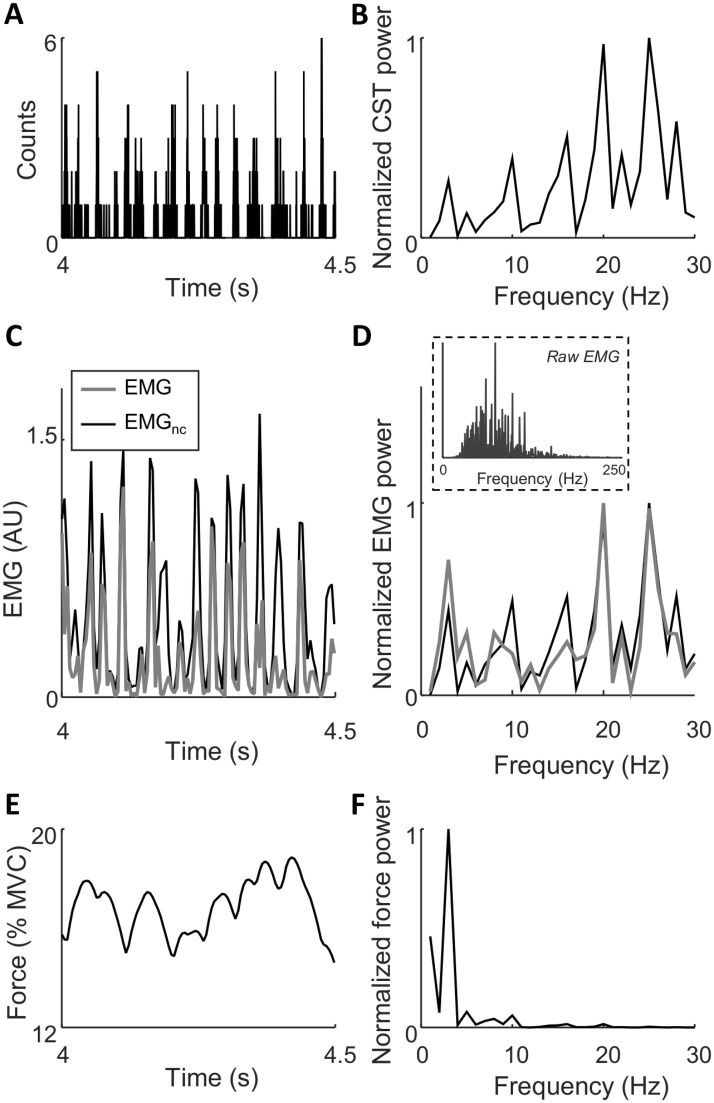
Temporal and spectral representation of the cumulative spike train (CST; A, B), the rectified EMG and EMGnc (C, D), and force (E, F).In panel D, the normalized power spectrum of the raw (unrectified) EMG signal in the 0–250 Hz range is included in the dashed box. In this example, the muscle consisted of 100 motor units, the amplitude of the variability of the common synaptic input was high (force standard deviation: 1.8%MVC), and the average contraction level was 14.9%MVC. The power spectra (B, D, F) indicate power only for integer frequencies that were the frequency components used to simulate the common input.